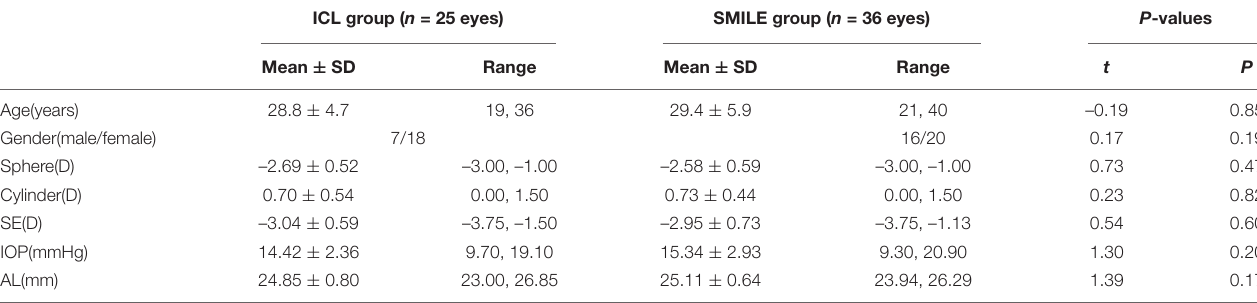
TABLE 1 | Demographic data and preoperative characteristics.